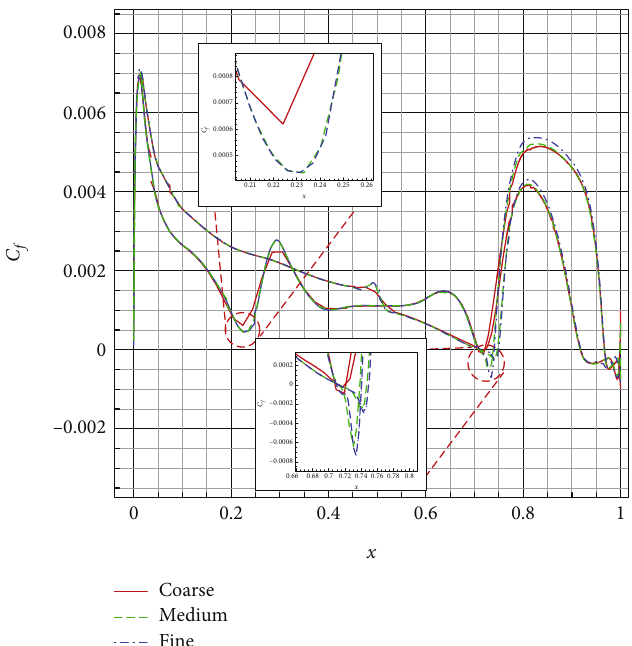
Figure 6: Friction distribution ( Re = 1 : 4 E 6 , α = 2 ° ).